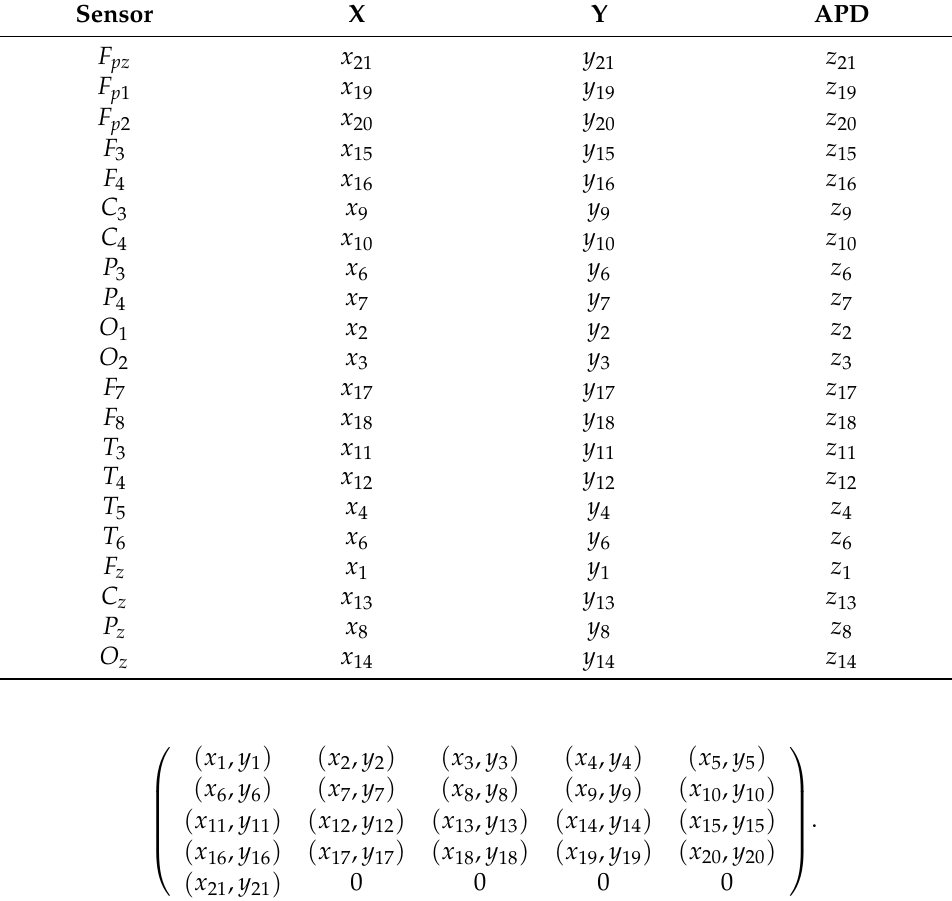
Table 2. Average potential difference (APD) at the sensor on a MC